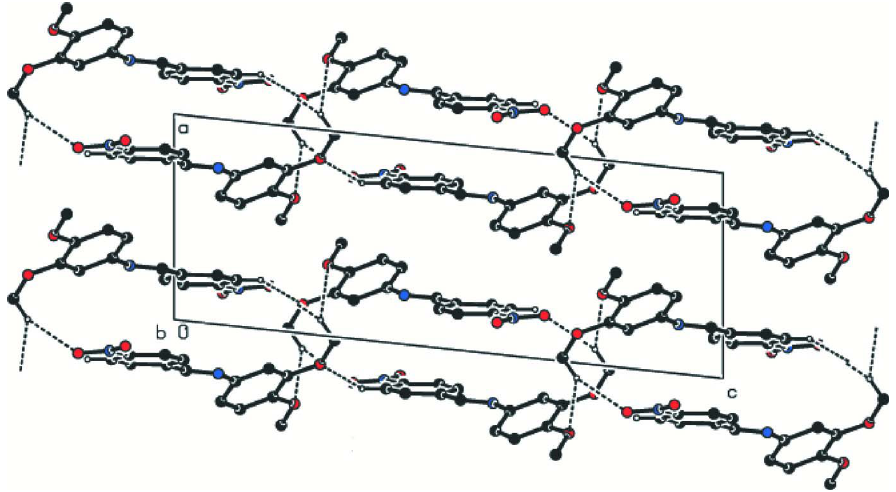
View of (I) showing with the atom-numbering scheme and 50% probability displacement ellipsoids